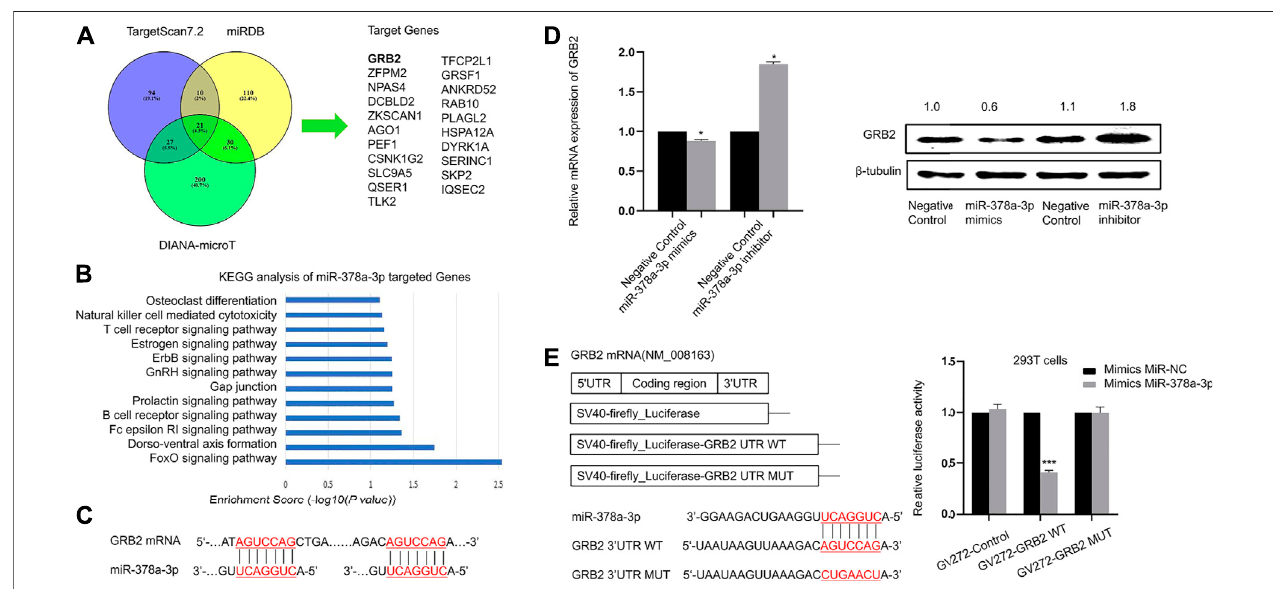
FIGURE5| miR-378a-3pdirectlytargetsGRB2inmurinealveolarmacrophages (A) .TargetgenepredictionofmiR-378a-3pwiththreebioinformaticstoolsandthe results are shown in the Venn diagram (B) . KEGG pathway analysis of target genes of miR-378a-3p (C) . The binding sites between miR-378a-3p and target gene GRB2 (D) .RT-qPCRandWesternblottingassayofGRB2expressioninMH-ScellstreatedwithmiR-378a-3pmimicsandmiR-378a-3pinhibitororcontrol (E) .Diagram of thewild-type and amutated-typeofbindingsite betweenmiR-378a-3p and GRB2and luciferase reporter assays for293T cellstransfectedwith GV272 vectors carrying GRB2-3 ′ UTR versus GRB2-MUT-3 ′ UTR in the absence or presence of miR-378a-3p mimics. (* p < 0.05, ** p < 0.01, *** p < 0.001 vs. control).